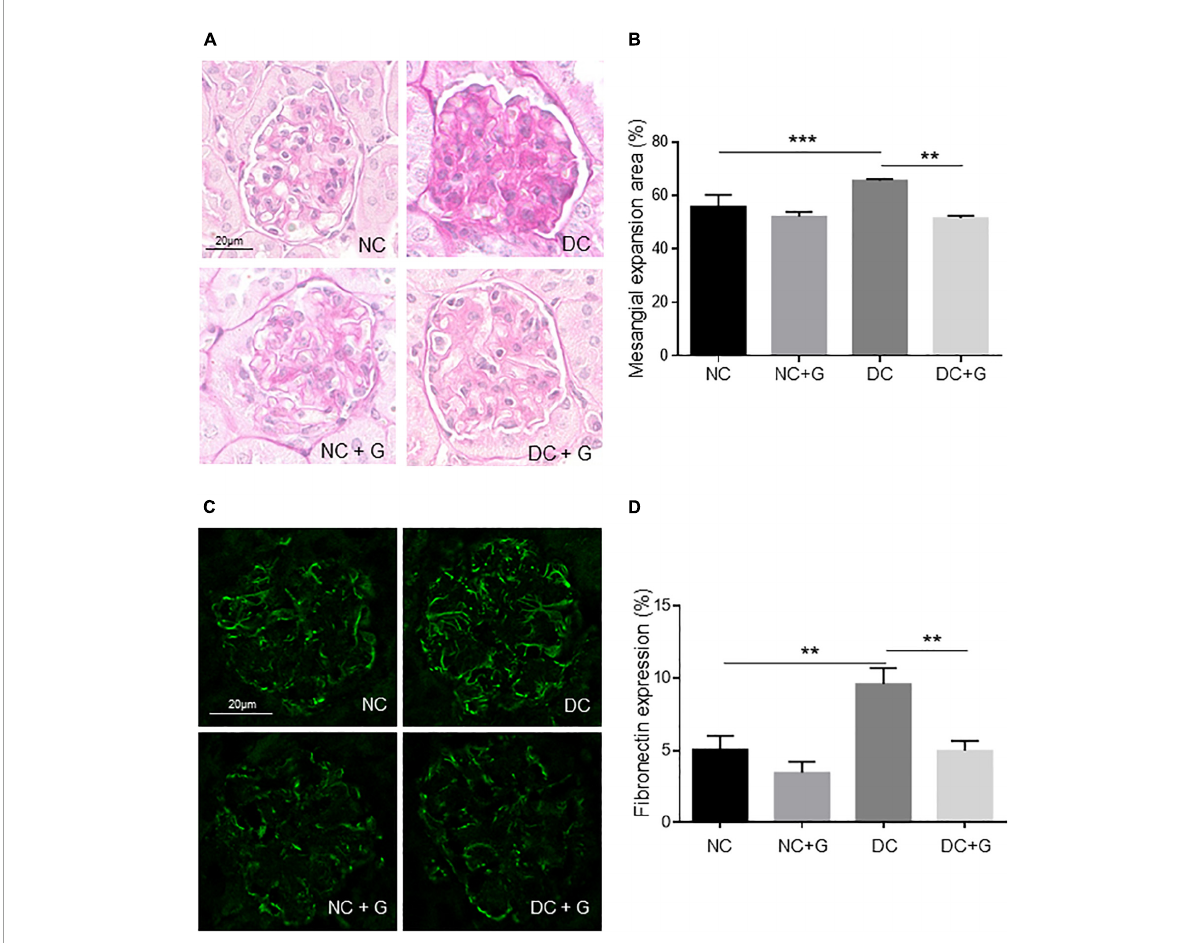
FIGURE1 Glucosamine decreases mesangial expansion in diabetic kidneys. (A) Representative renal histology in diabetic mice treated with glucosamine. Kidney sections were stained with periodic acid-schiff (PAS). The PAS positive stained mesangial matrix was assessed and presented in panel (B) . (C) Immunofluorescence staining of fibronectin in the glomeruli of non-diabetic and diabetic mice treated with and without glucosamine. (B) Quantification of the fibronectin expression. Data are presented in mean ± SEM, n is 5 for (B) , and 20 for (D) fibronectin expression was verified in three individual serials. ** p < 0.01, *** p <